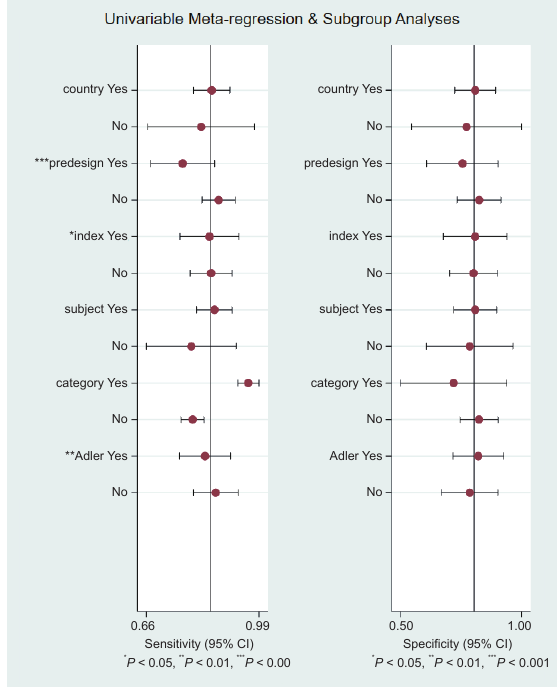
Figure 5 The forest plots of subgroup